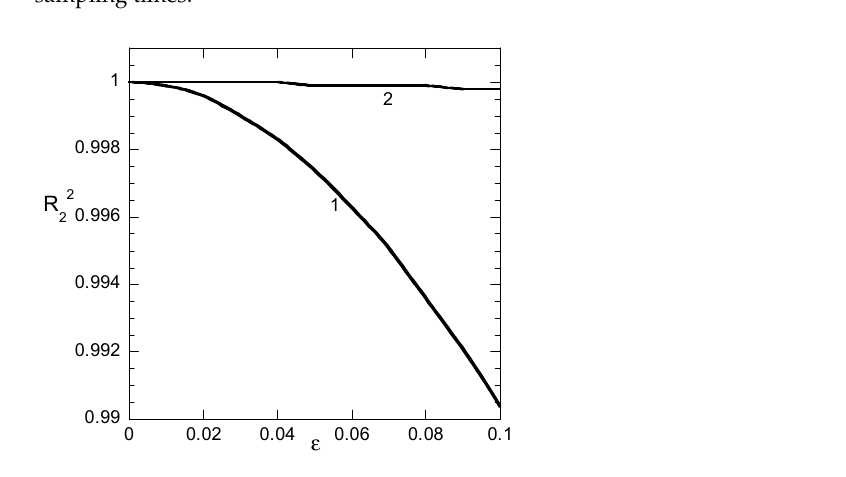
Figure 5. Example 3: Pseudo-second order linear fit correlation coefficient R 22 versus “experimental error” parameter ε , Curve 1: Case 1 sampling times, Curve 2: Case 2 sampling times.